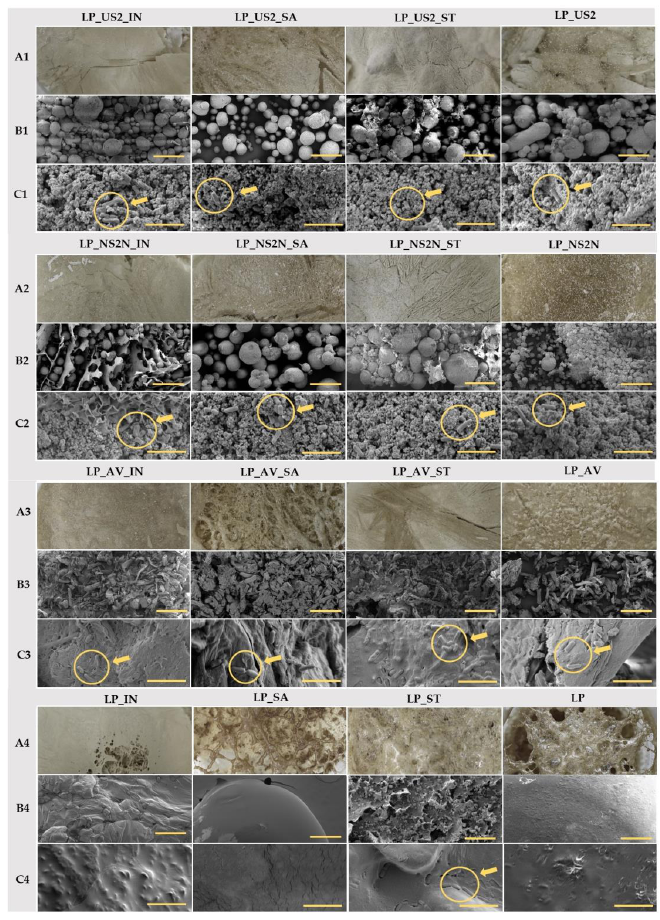
Figure 4. Lyophilized samples containing bacteria in three different types of images: ( A ) macroscopic; ( B ) SEM images in the view field of 1000 μm with a bar corresponding to 200 μm; and ( C ) SEM images in the view field of 20 μm with a bar equivalent to 5 μm. The circle with a pointing arrow directly indicates the lactobacilli body.